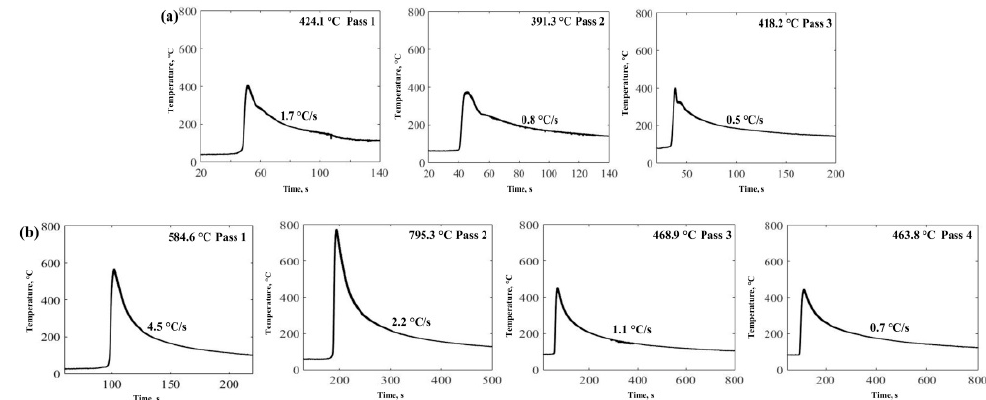
Figure 4. Thermal cycle curves for each pass during welding for the ( a ) 1670-8 and ( b ) 1670-14.